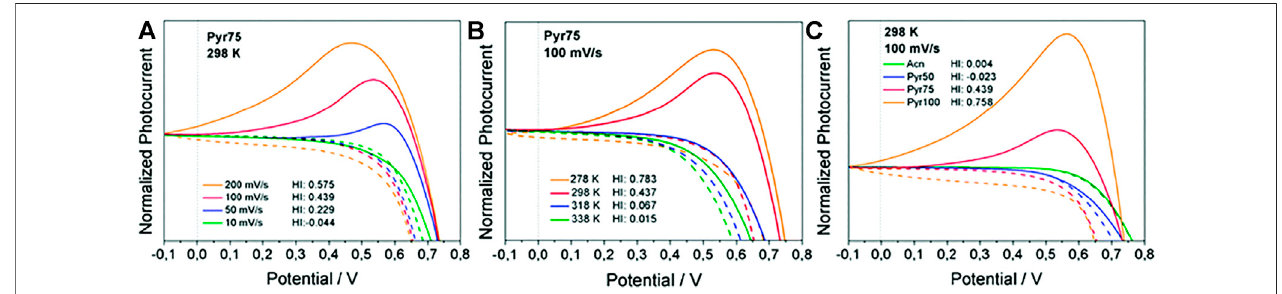
FIGURE 2 | Normalized (reference voltage: − 0.1 V) current – voltage curves of DSCs measured in the reverse scan (line) and forward scan (dash line) under a light intensity of 10 mW cm − 2 using a green LED. The in fl uence of hysteresis-determining factors is speci fi cally shown: (A) scan rate, (B) temperature, and (C) electrolyte solvent. Reproduced from (Contreras et al., 2016).